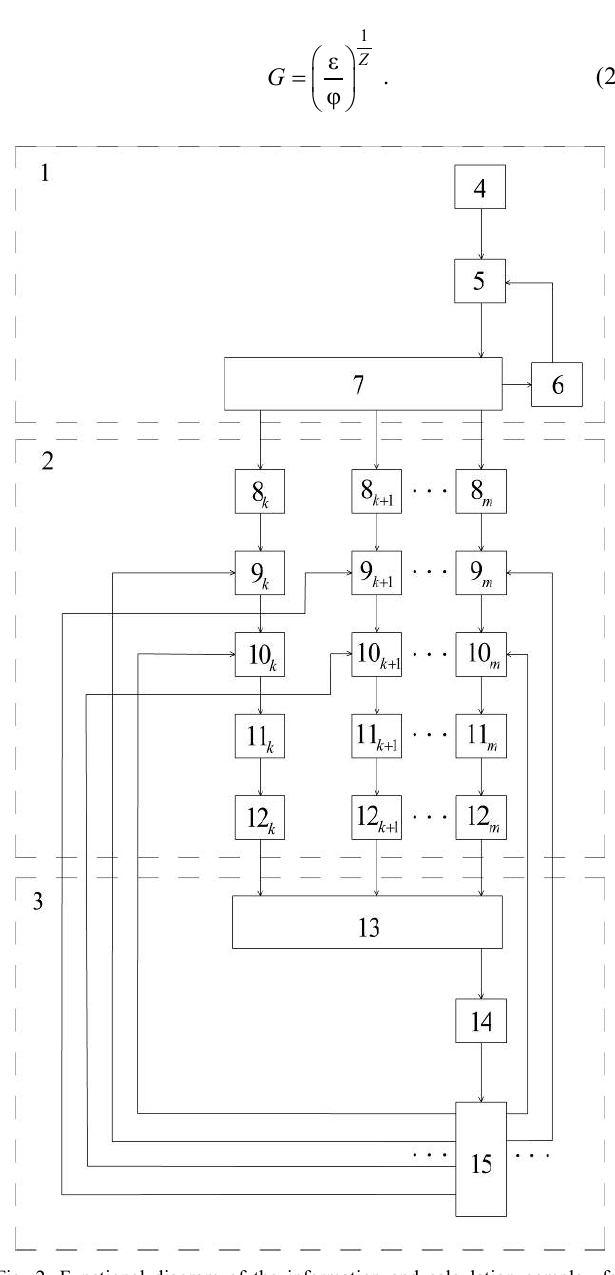
Fig. 2. Functional diagram of the information and calculation complex for calculating the centrifugal compressor: 1 – data entry program block, 2 – data calculation and accumulation program block, 3 – parametric optimization program block, 4 – initial data processing block, 5 – number of steps calculation block, 6 – step number refinement block, 7 – data generation block for calculation of the parameters of each stage, 8 k , 8 k+ 1 , 8 m – blocks for determining the main dimensions of the impeller and diffuser, 9 k , 9 k +1 , 9 m – blocks for determining the geometric parameters of the blades of the impeller, 10 k , 10 k+ 1 , 10 m – blocks for determining the geometric parameters of diffuser blades, 11 k ,